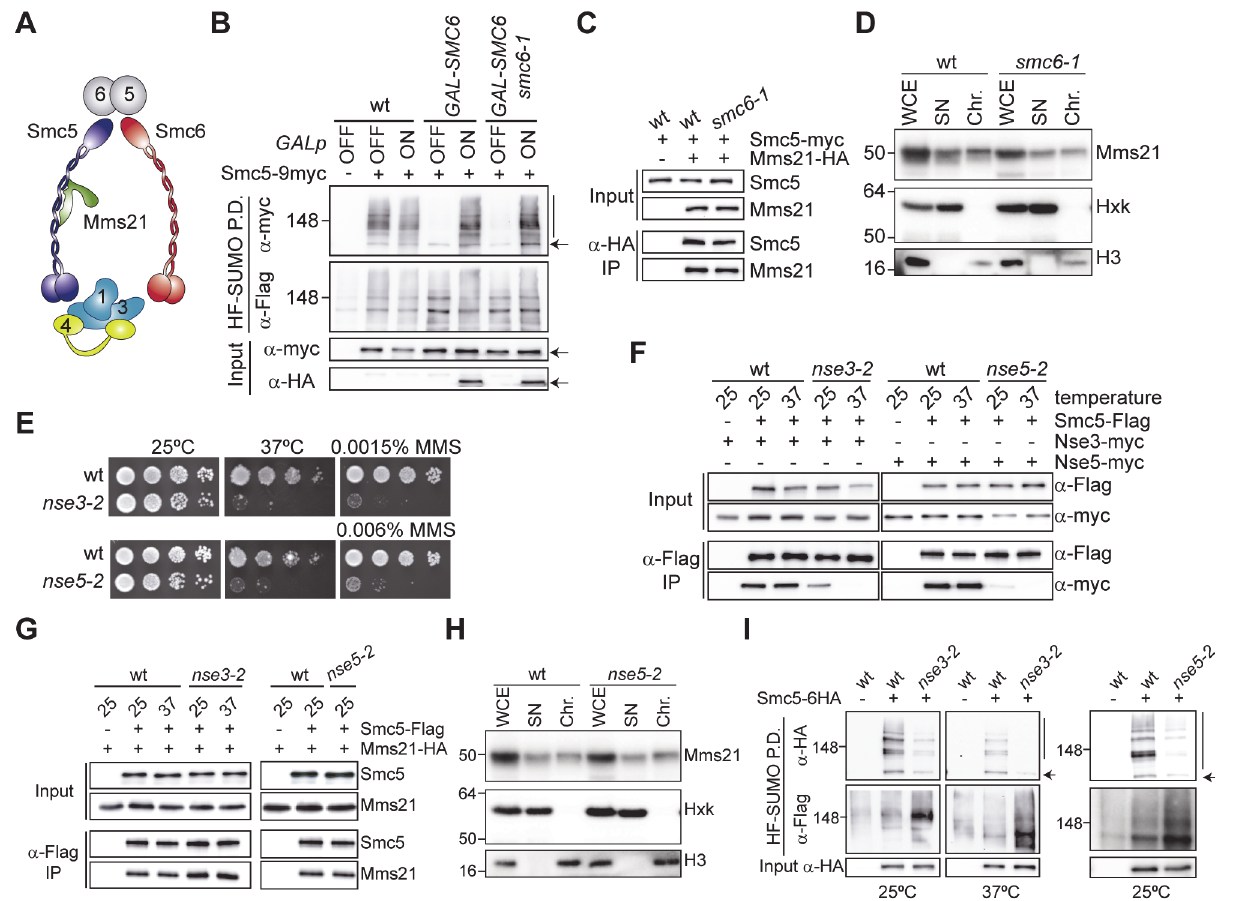
Fig 2. Mms21-dependent sumoylation requires an intact Smc5/6 complex. A . Composition of Smc5/6, depicting the different entities present in the complex. Nse subunits are labeled 1 to 6; Nse2 = Mms21. B . Sumoylation of Smc5 in smc6 mutant cells. Samples of wild type and GAL-3HA-SMC6 were collected from cells growing exponentially in galactose ( GALp ON), or 12 h after shift to glucose to repress 3HA-SMC6 expression ( GALp OFF). A GALp- 3HA-SMC6 strain expressing the smc6-1 allele from a centromeric vector was also included in the analysis. Protein extracts were processed for HF-SUMO pull down as in Fig. 1G. C . Co-immunoprecipitation analysis of the Smc5-Mms21 interaction from wild type and smc6-1 protein extracts. Wild type and GALp- SMC6 smc6-1 cells expressing Smc5-9myc and Mms21-6HA were shifted to glucose for 12 h and processed for anti-HA immunoprecipitation. D . Chromatin fractionation assay from wild type and smc6-1 cells to analyze the amount of chromatin-bound Mms21-6HA. Controls for a chromatin-bound protein (histone H3) and cytoplasmic soluble (Hexokinase; Hxk) proteins are shown. E . Temperature and methyl methanesulfonate (MMS)-sensitivity of nse hypomorphic alleles. Growth test of wild type, nse3-2 , and nse5-2 cells in YPD plates at 25°C (containing or not the indicated MMS concentration) or at 37°C. F . Analysis of the Smc5-Nse3 and Smc5-Nse5 interaction in nse hypomorphic alleles. Exponentially growing Smc5-6Flag cells, expressing 9myc-tagged versions of either the wild type or the indicated hypomorphic nse alleles, were shifted to 37°C for 2 h (37) or kept at 25°C (25) before Smc5-6Flag immunoprecipitation. G . Co- immunoprecipitation analysis of the Smc5-Mms21 interaction in nse3-2 and nse5-2 mutant cells. Smc5-6Flag was immunoprecipitated, as in F, from cells grown at the indicated temperatures. Co-immunoprecipitation of Mms21-6HA was analyzed by western blot. H . Chromatin fractionation assay from Mms21- 6HA tagged wild type and nse5-2 cells, as in D. I . HF-SUMO pull down from wild type, nse3-2 , or nse5-2 cells expressing Smc5-6HA, before and after a shift to 37°C. In B and G, arrow points to unmodified form of the proteins, vertical bar to sumoylated forms. In D and H, WCE: Whole Cell Extract; SN: Supernatant; Chr: Chromatin fraction.